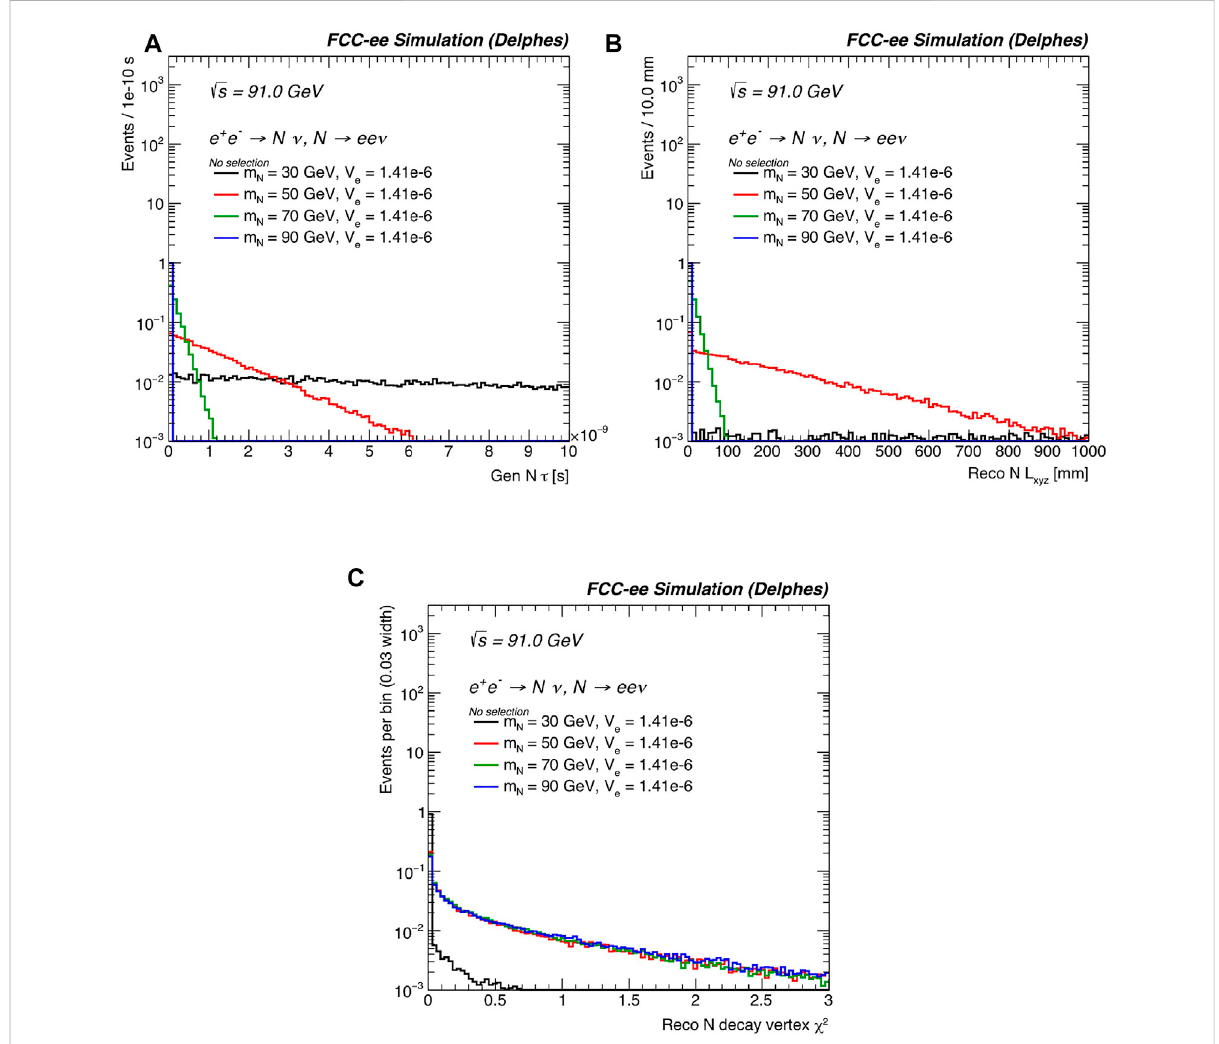
FIGURE 14 For the same processes and benchmark mass and | V eN | choices as in Figure 12, the differential distributions with respect to (A) the generator- level lifetime of N in the lab frame; (B) the reconstruction-level three-dimensional decay length of the N ; and (C) the χ 2 of the reconstructed decay vertex of the HNL are shown. No selection criteria have been applied. The distributions are normalized to unit